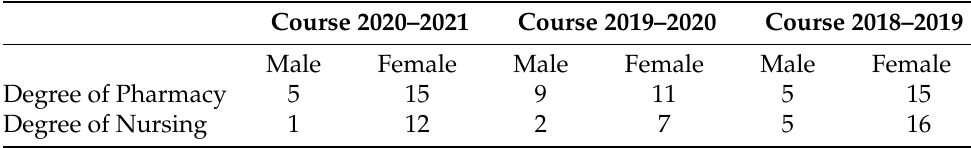
Table 2. No. of male and female according to the